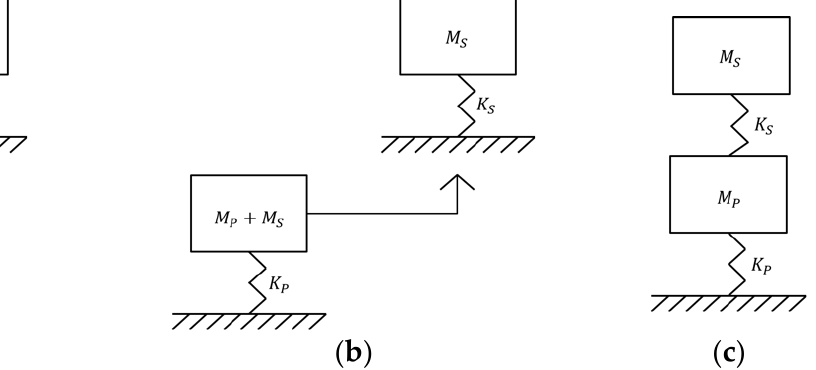
Figure 17. Different models of a coupled system: ( a ) Model A; ( b ) Model B; ( c ) Model C.